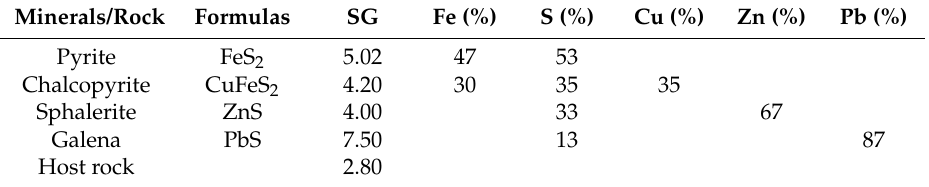
Table 1. Main minerals of Zambujal, chemical formulas, specific gravity, and theoretical metal grades.